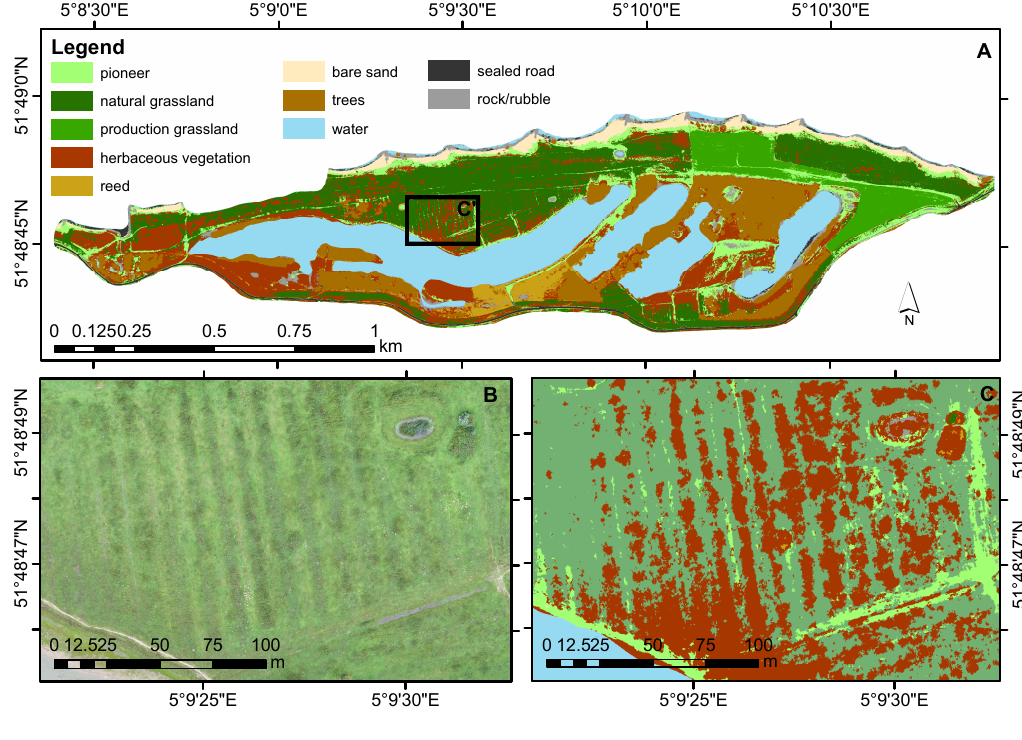
Figure 5. Classified land-cover map of the Breemwaard floodplain with data from the best performing RF, which used data from all time steps and maxnodes set to default. ( A ) Overview of the classified study area. ( B ) Orthophoto of September of zoomed in area C’ and ( C ) zoomed in area of classified grassland and herbaceous